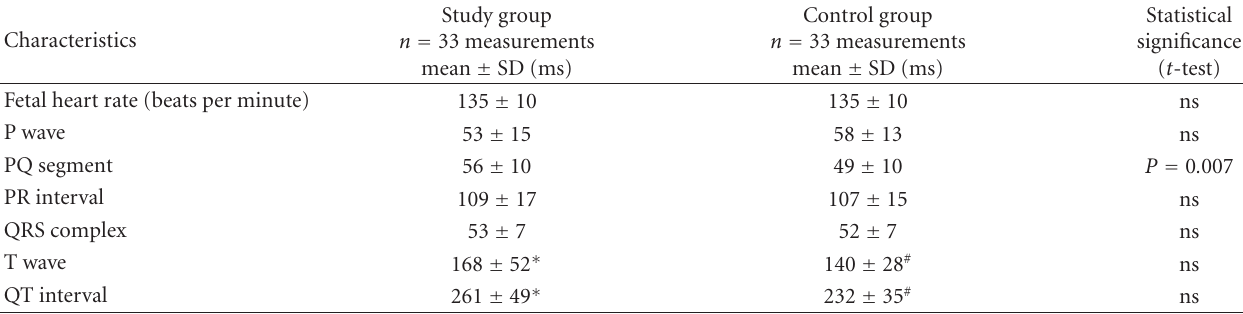
Table 2: Fetal cardiac time